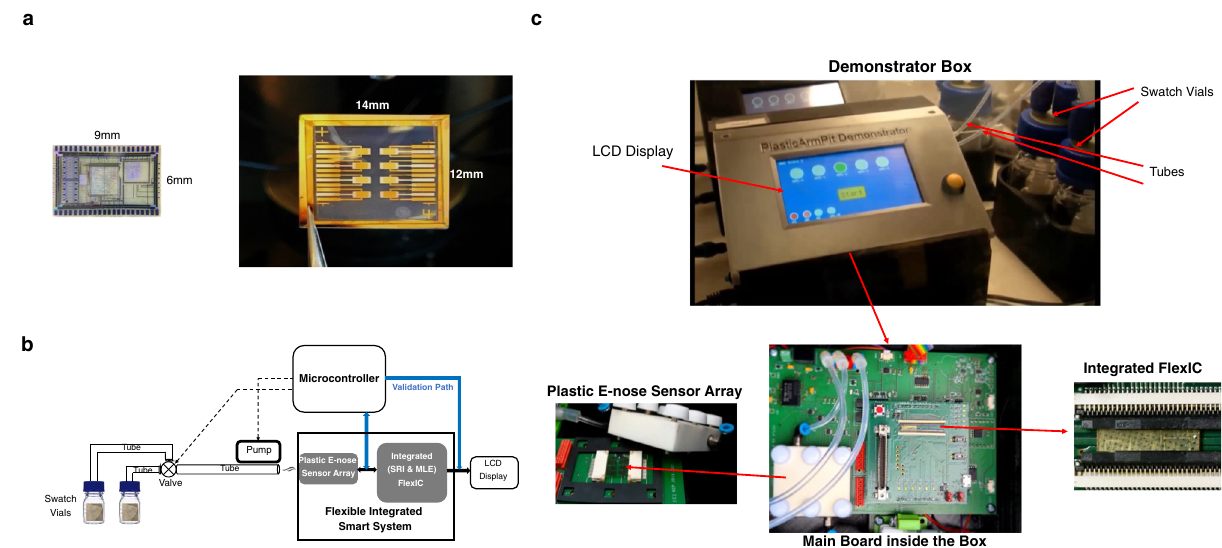
Fig. 8 | System prototypes. a Die photos of the FlexIC integrating SRI and MLE (left),and OFET devices fabricatedon a PENsubstrate(right).The sensor array has eight sensors made up of four types of OFETs with redundant replicas. Only four sensors are used and powered on. b The high-level architecture of the demon- strator system. The blank and malodour swatches are placed into two vials. The headspace in vials is sucked into the tubes through the pump. The vial selection is controlled by a valve that allows only the headspace from the selected vial to be sucked into the main tube. The long tube carries the headspace onto the plastic e-nose sensor array. The sensor outputs are captured both by the microcontroller on the validation path and the FlexIC on the fl exible integrated smart system. The